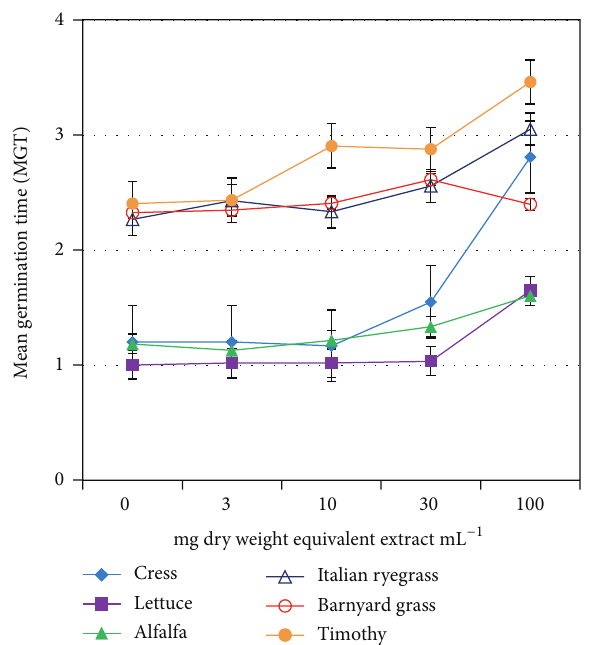
Figure 4: Effect of aqueous methanol extracts of O. tenuiflorum on MGT of different plant species at four different concentrations. Other details are the same as Figure